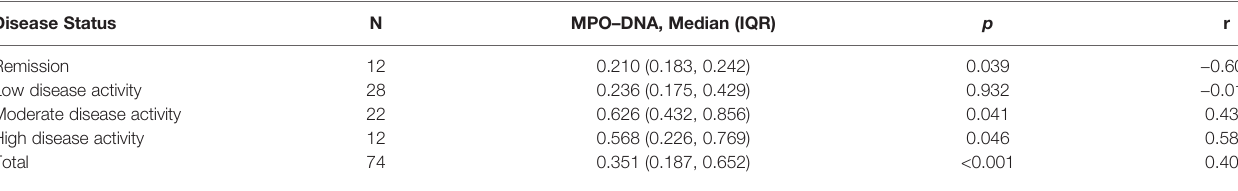
TABLE 3 | Correlation of serum MPO – DNA levels with DAPSA score in patients with PsA with different disease activity. Disease Status